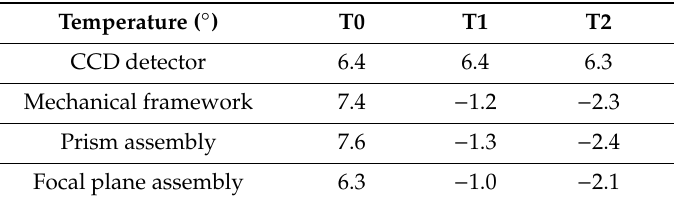
Table 3. Temperature of di ff erence parts for the prism